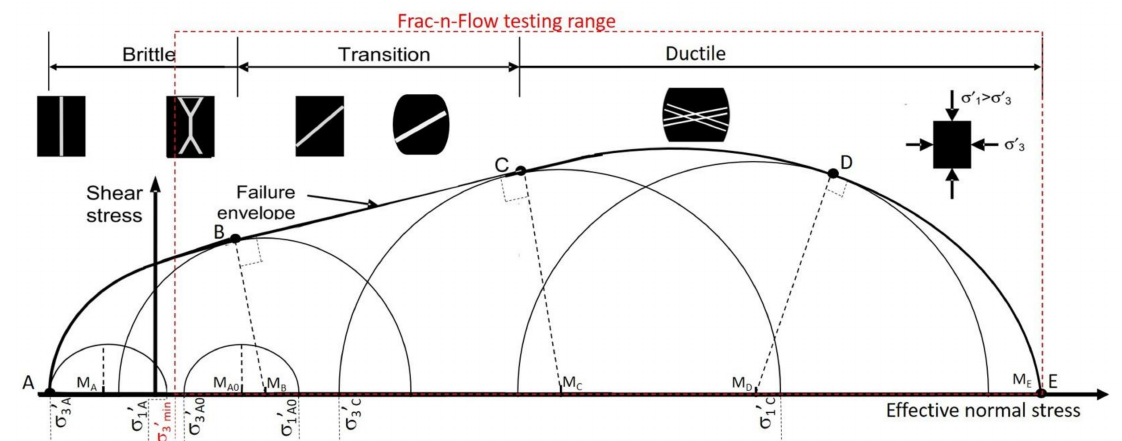
Figure 7. Frac-n-flow testing range in 3-D effective stress space with failure envelop ABCDE and representative Mohr’s circles M A , M B , M C , M D and M E at failure. M A —triaxial extension failure, M A0 —initial Mohr’s circle before injection; M B and M C —triaxial shear failure; M D —triaxial non-hydrostatic compaction failure, and M E —triaxial hydrostatic com- paction failure. σ 1 (cid:48) A0 , σ 1 (cid:48) A and σ 1 (cid:48) C —axial effective stresses of Mohr’s circles M A0 , M A and M C; σ 3 (cid:48) A0, σ 3 (cid:48) A, and σ 3 (cid:48) C —radial effective stresses of Mohr’s circles M A0 , M A and M C . σ 3 (cid:48) min —minimum radial effective stress required to seal rock sample sleeve, 30 psi and 200 psi recommended for thin and thick sleeves,